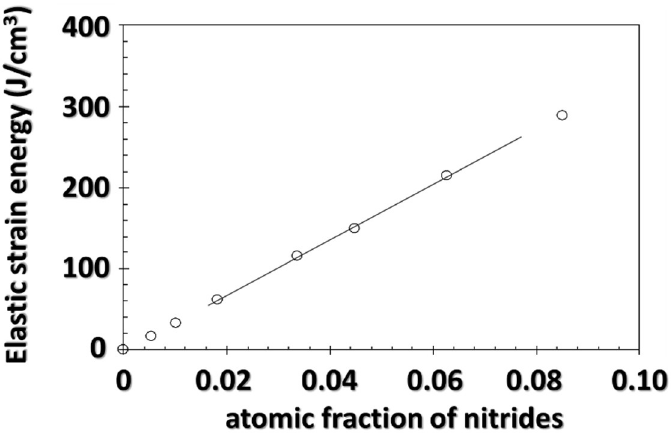
Figure 13. Evolution of the stored elastic strain energy as a function of the atomic fraction of nitrides, based on mechanical calculations.